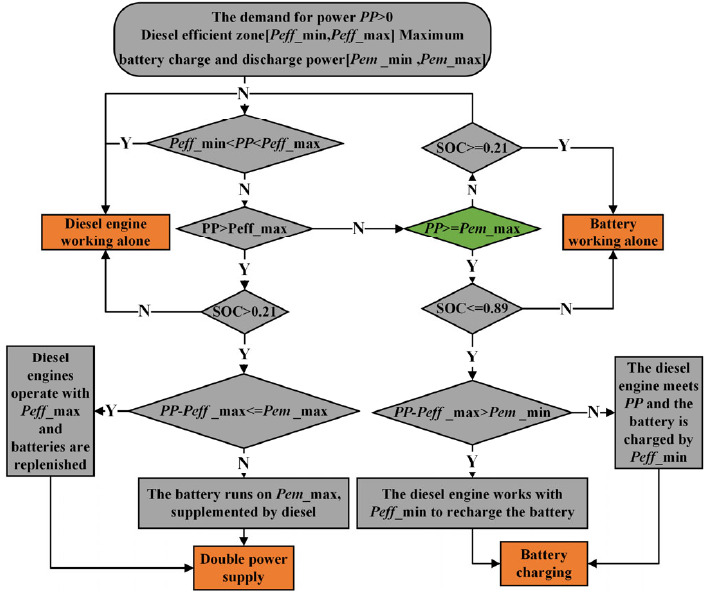
Figure 6. Flow chart of RB strategy when PP > 0.